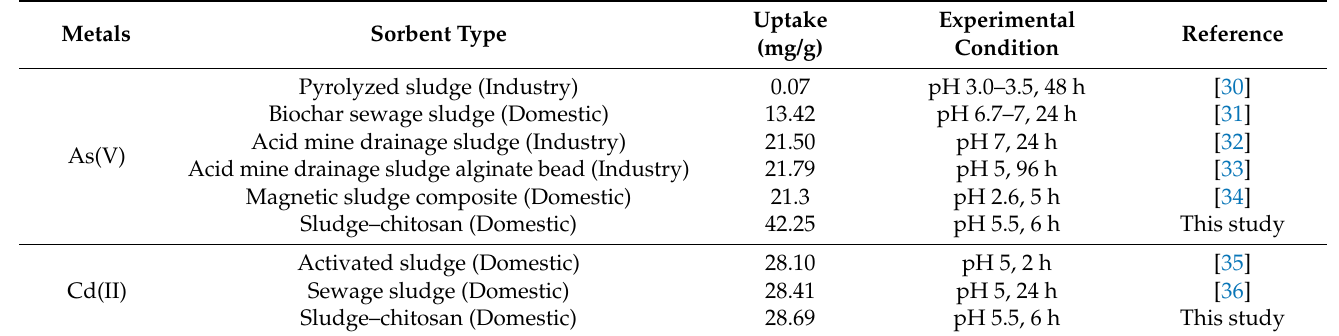
Table 4. Maximum uptakes of metals (As(V) and Cd(II)) by various biosorbents manufactured from